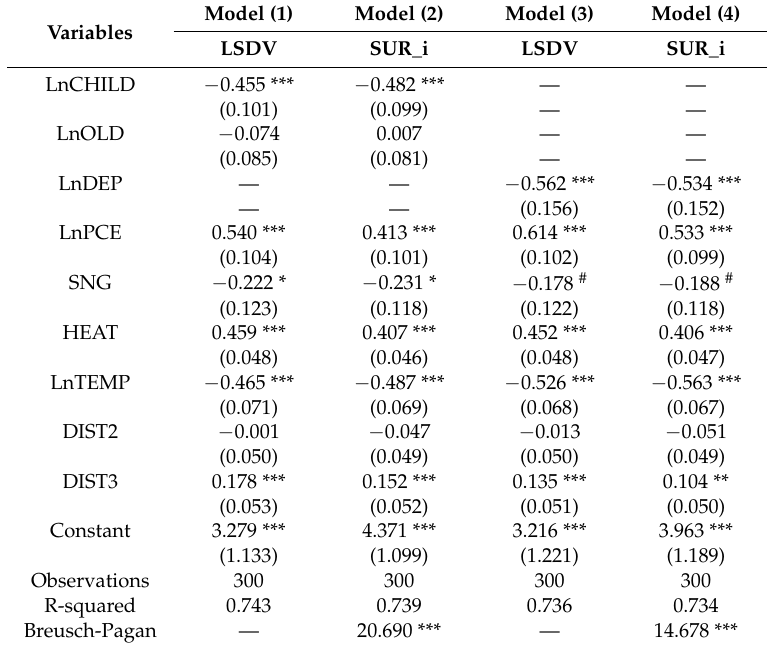
Table 3. Determinants of urban residential energy consumption per capita